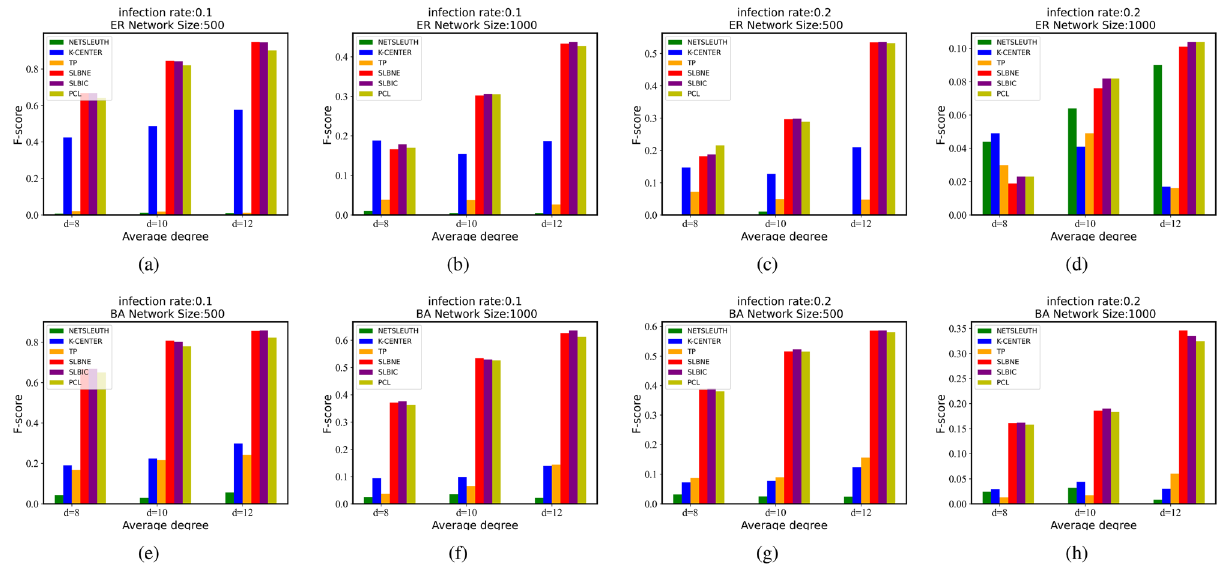
Figure 5. Sources localization accuracy in synthetic networks. ( a – d ) Results in ER network. The scale of the network is N = 500, 1000 respectively, the node infection rate is 0.1, 0.2 respectively, the average degree is 8, 10, 12 respectively. ( e – h ) Results in BA network. The number of source nodes is